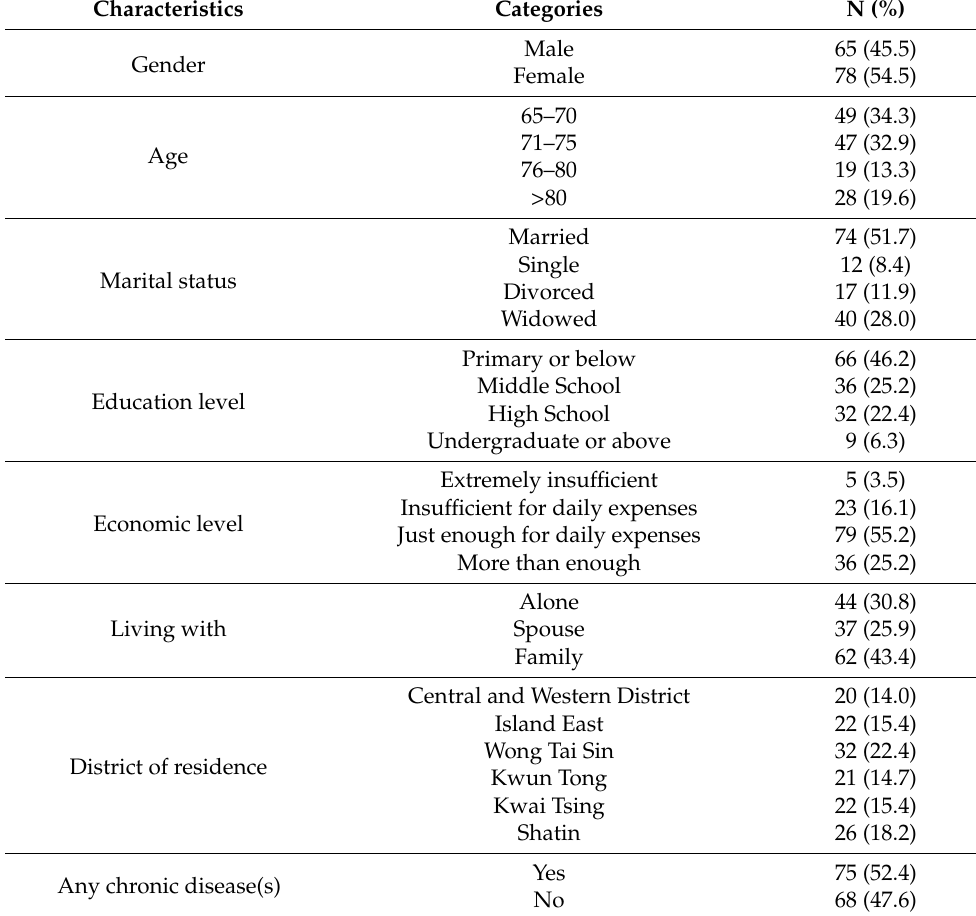
Table 1. Demographic characteristics of the subjects ( n = 143).